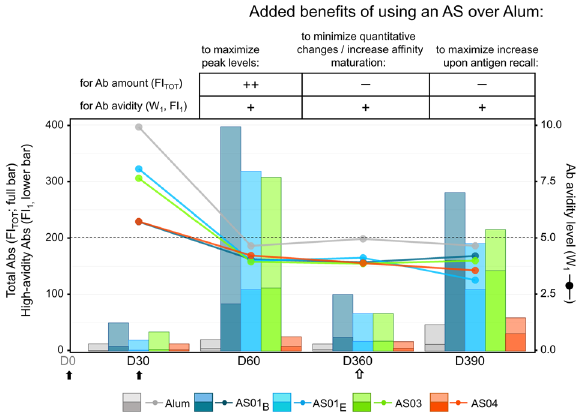
Fig. 5 Bene fi ts of Adjuvant Systems over Alum for vaccine antibody responses. Schematic presentation of the bene fi ts of using an Adjuvant System (AS) over Alum to formulate HBsAg vaccines is presented for the different aspects of the antibody (Ab) response. The immunization schedule comprised two primary vaccinations administered at day (D)0 and D30 (solid arrows) and a non-adjuvanted antigen recall (open arrow) administered at D360. The table summarizes the expected added bene fi ts of the adjuvant choice (an AS or Alum) for enhancement of quantitative and qualitative aspects of the response at different timepoints post- vaccination or after antigen recall; ‘ ++ ’ and ‘ + ’ denote signi fi cant and moderate-to-slight enhancement, respectively, and ‘–’ denotes no clear bene fi t, i.e., similar proportional decline/enhancement for AS and Alum. The graph shows the abundance of HBsAg-speci fi c Abs (total fl uorescence intensity [FI TOT ]; full bars), the relative abundance of high-avidity speci fi c Abs ( fl uorescence intensity of the fi rst component Abs [FI 1 ]; the bottom part of bars), and Ab avidity levels (W 1 ; lines/symbols). Bars, lines, and symbols are color-coded according to the adjuvant groups presented below the graph. The horizontal dotted line represents the threshold for high avidity, with high-avidity pro fi les de fi ned as W 1 <